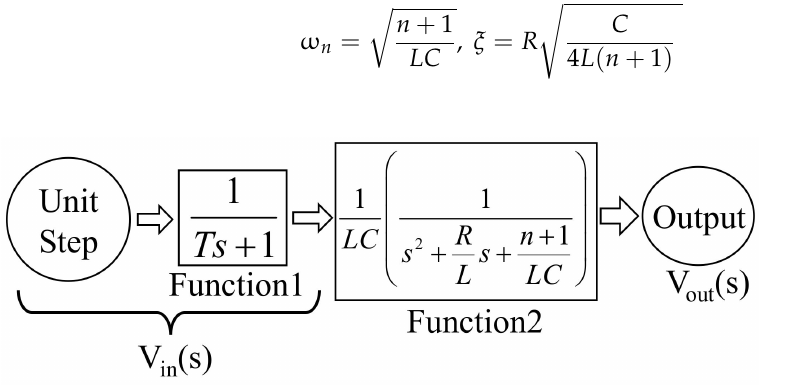
Figure 8. Transfer function of the simplified circuit